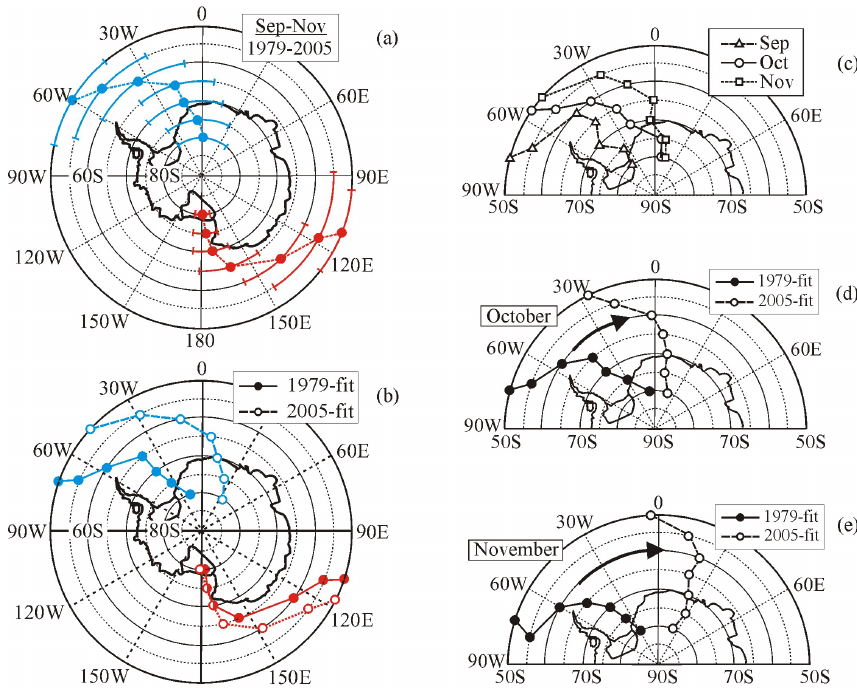
Fig. 6. (a) The 1979–2005 mean longitudinal position of the zonal wave extremes with the standard deviation bars; (b) initial (1979, closed circles) and final (2005, open circles) extreme positions obtained from the linear fits shown in Fig. 5; (c) monthly mean positions of zonal minimum for September (triangles), October (circles) and November (squares) and (d, e) eastward shift of zonal minimum during 1979–2005 in October and November, respectively, estimated by linear